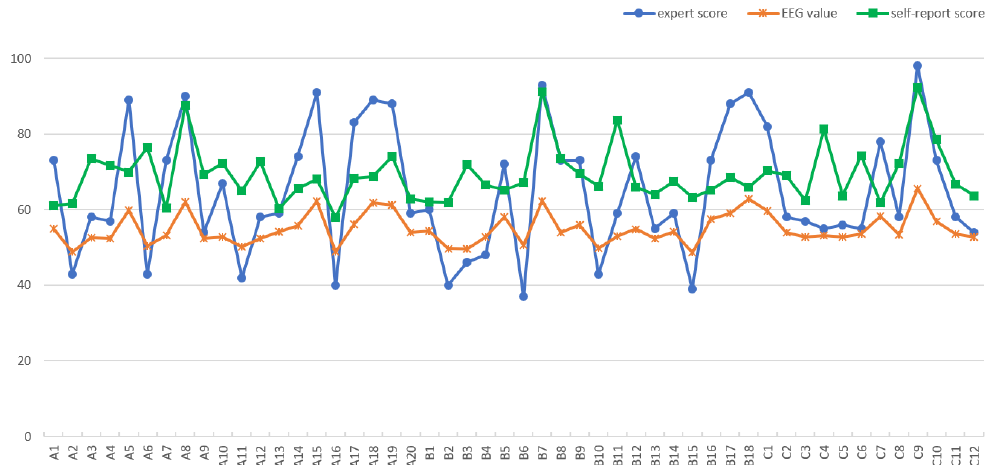
Figure 3. Line chart of the results of the expert approach and EEG method.